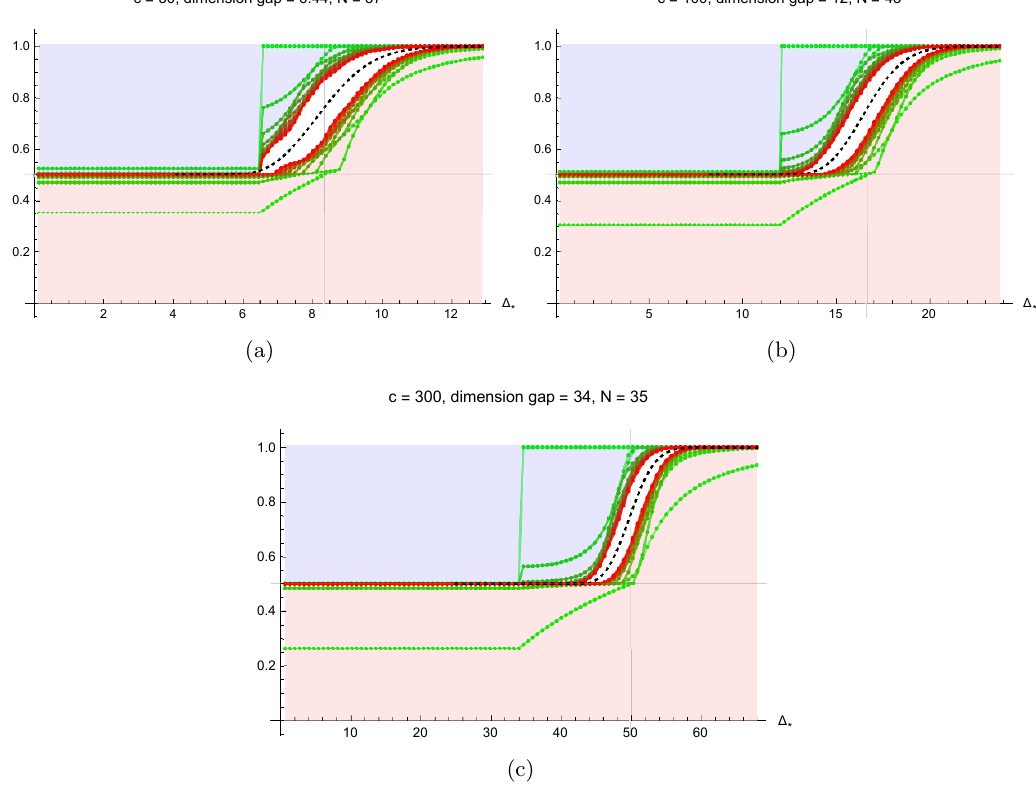
Figure 9 . Upper and lower bounds on the modular spectral function in the case that the dimension gap is close to the maximal value allowed by modular invariance for c = 50 ; 100 ; 300. The dotted black curve shows the modular spectral function of perturbative pure gravity due to the thermal AdS 3 and Euclidean BTZ saddles in the gravitational path